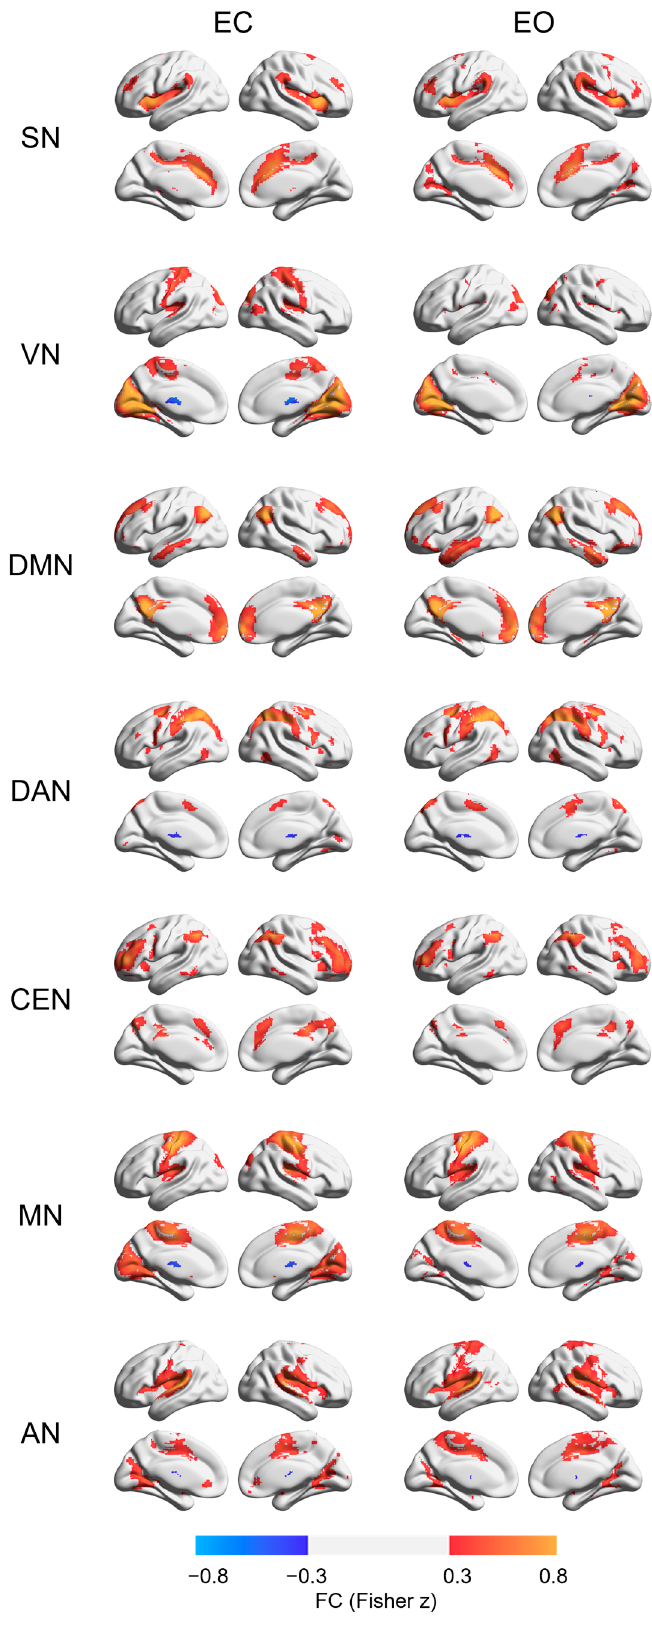
Figure A2. Seven FC maps of networks in EC and EO conditions based on New Taipei City dataset. The left and right column displays the FC maps of each network in EC and EO conditions, respectively. The color range of FC maps represents the Fisher z value from − 0.8 to − 0.3 and from 0.3 to